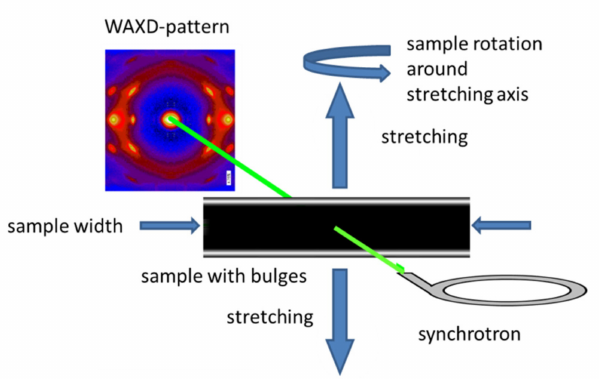
Figure 1. Arrangement of the stretched sample in the beam of the synchrotron source. The equatorial reflections have the indices (2 0 0) and (1 2 0), here a pattern of a fiber symmetrical sample is